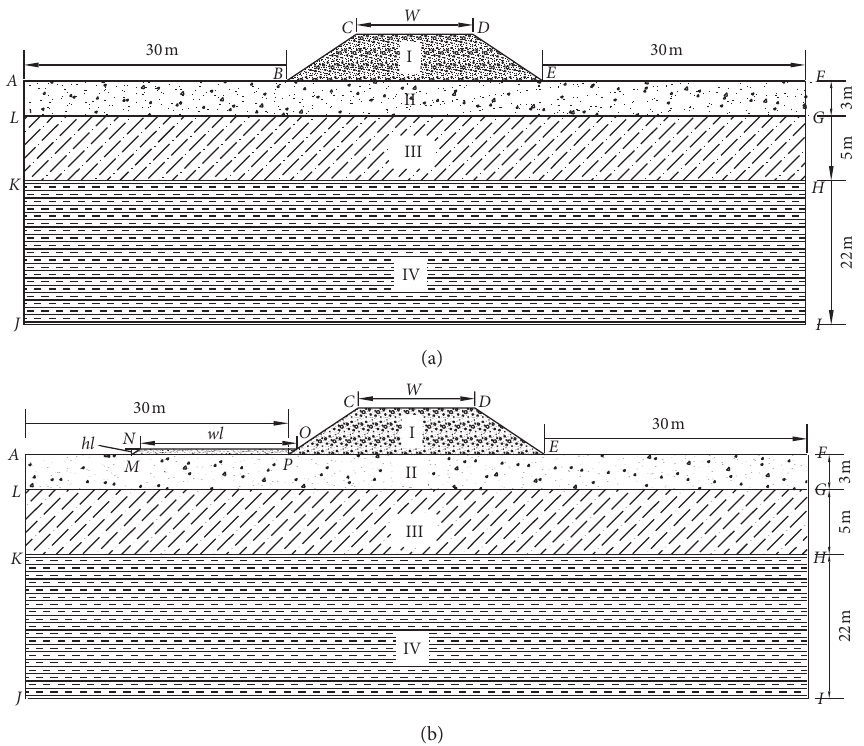
Figure 2: Schematic diagrams of expressway embankment: (a) no sand embankment; (b) unilateral sand